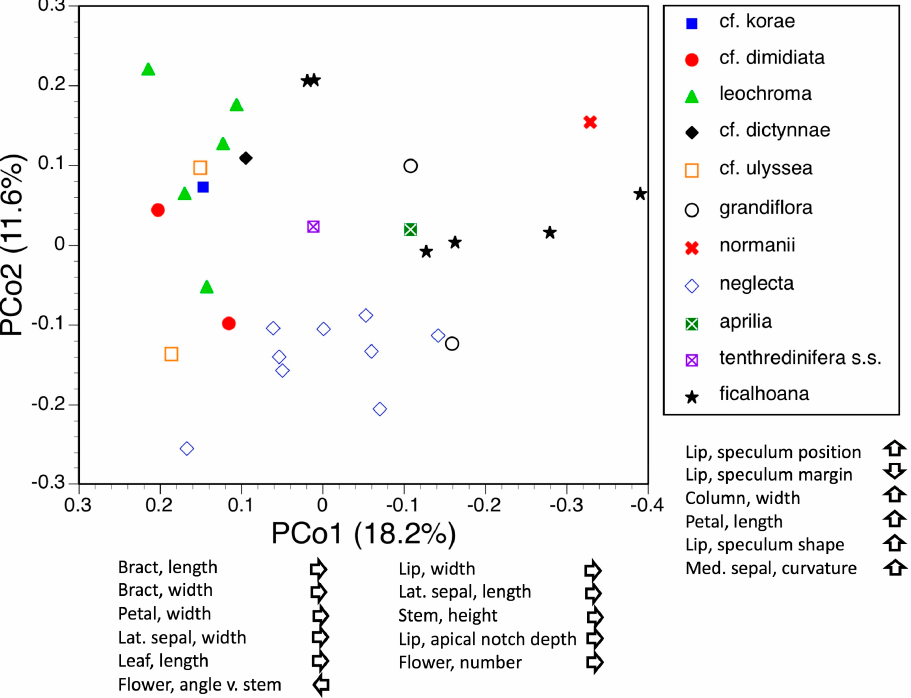
Figure 10. Plot of principal coordinates 1 and 2 for the macrospecies Tenthredinifera, labelled according to nine mesospecies groups: 31 individuals from 27 localities and 47 variable characters. Characters contributing to each coordinate are listed in descending order, with arrows indicating the direction of increase in the value of each character.